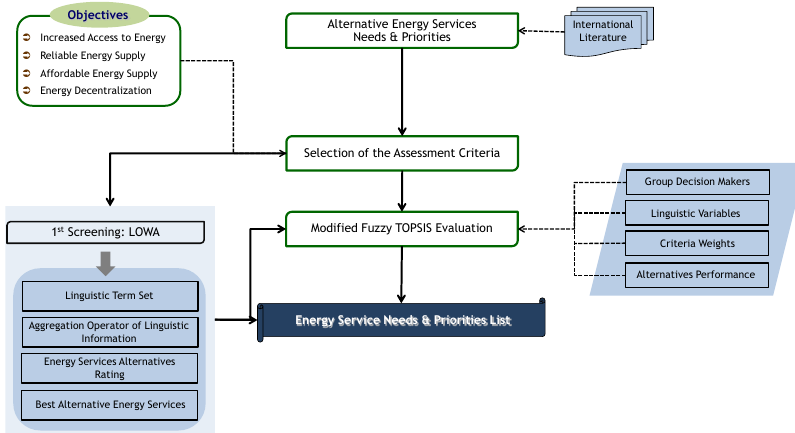
Figure 3. 1st component—assess.